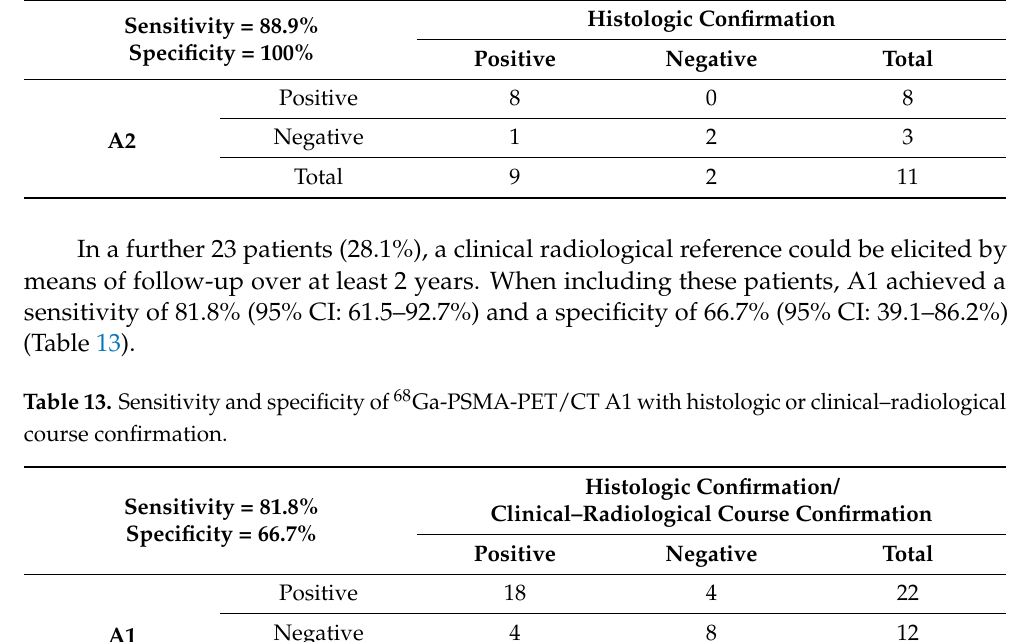
Table 12. Sensitivity and specificity of 68 Ga-PSMA-PET/CT A2 with histologic confirmation. Sensitivity = 88.9% Specificity = 100% Positive